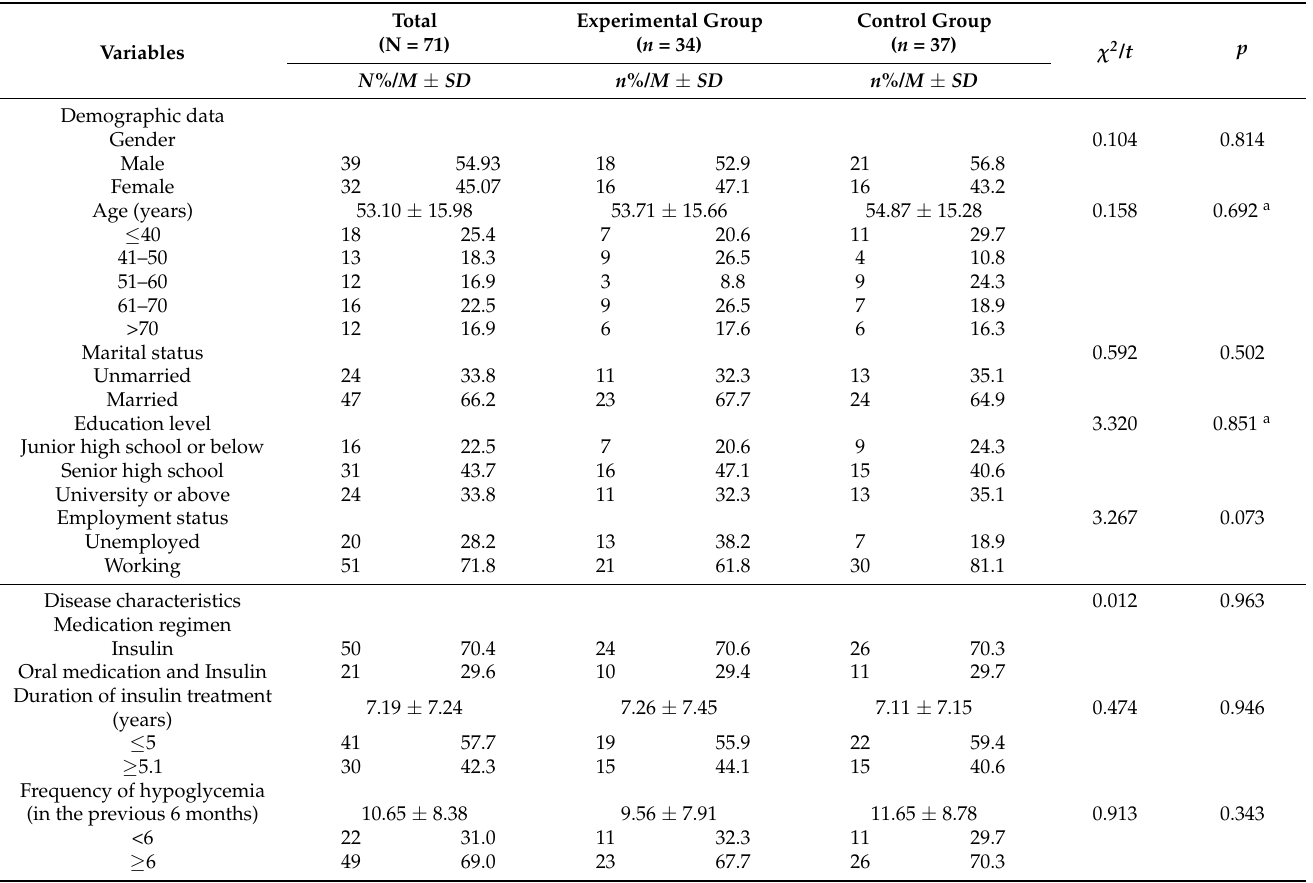
Figure 1. Recruitment for the Hypoglycemia Problem Solving Program. Table 2. Homogeneity test of the demographic and disease characteristics of the two groups (N = 71).